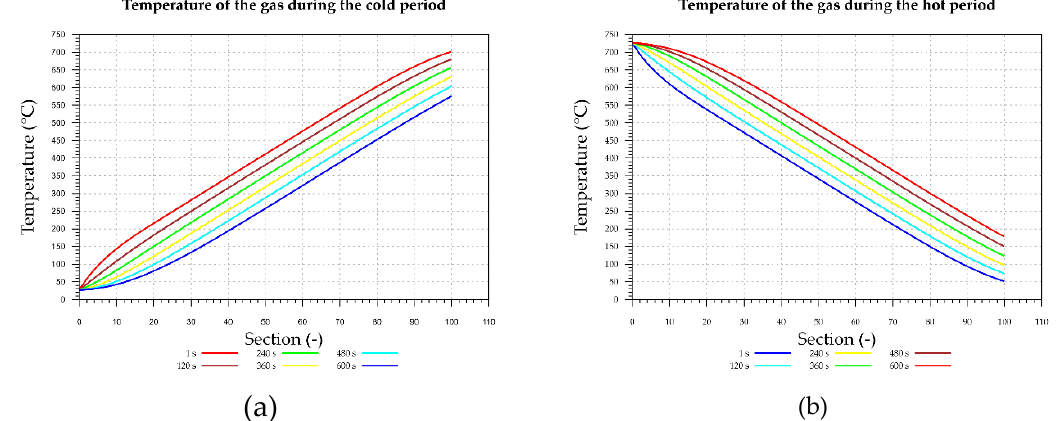
Figure 9. The graphical dependences of gas temperatures along the bed: ( a ) for the cooling period; ( b ) for the heating period.